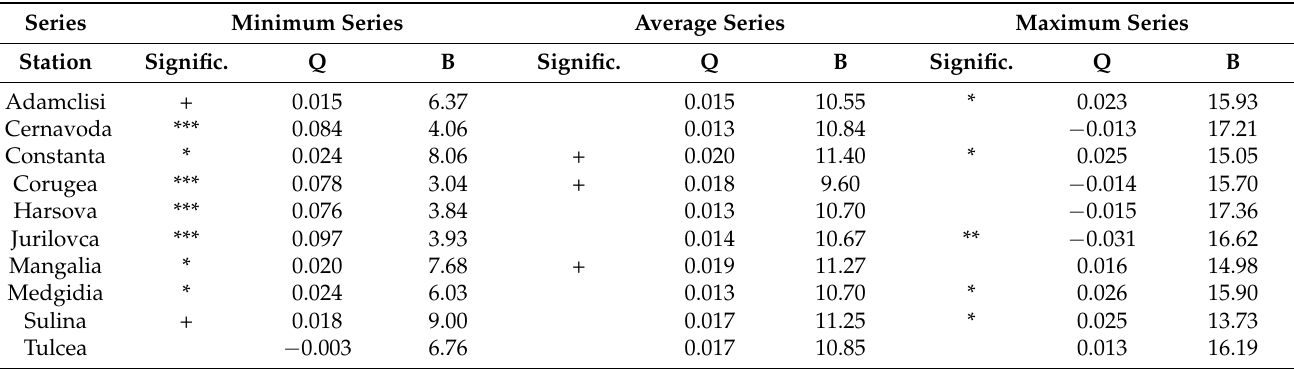
Table 1. Results of the Mann–Kendall trend